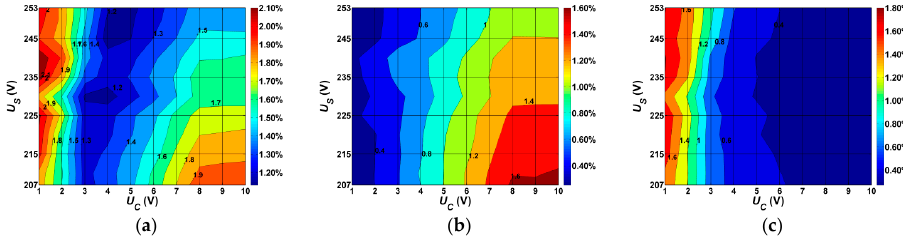
Figure 4. Active power losses in a street lighting circuit with 30 luminaires as percentages of the circuit power P kc : ( a ) total power losses Δ P TOTAL ; ( b ) active power losses caused by the flow of active power Δ P a ; ( c ) active power losses caused by the flow of reactive power Δ P r .